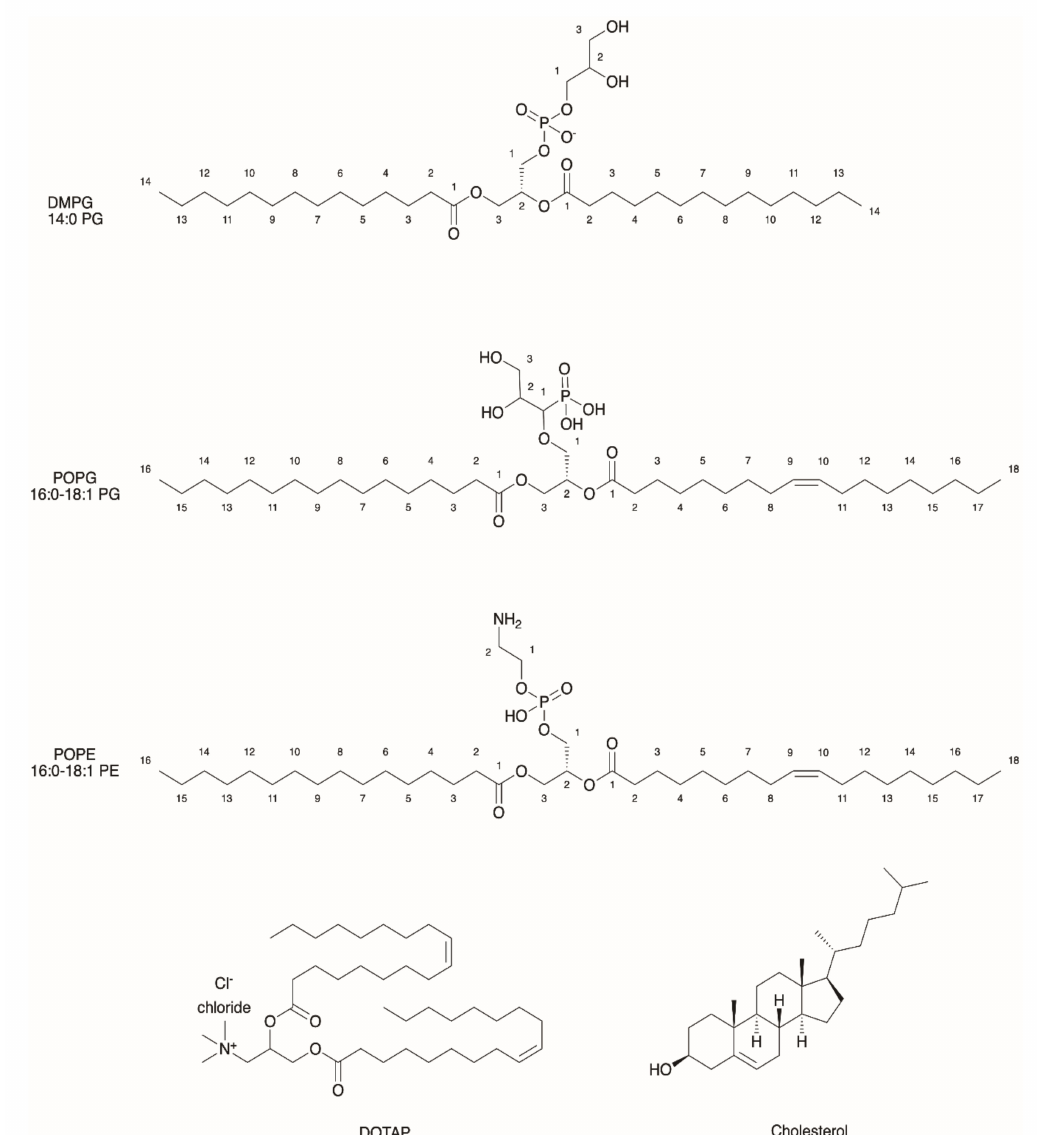
Figure 2. Structures of further lipids (apart from phosphatidylcholines) that were used for the generation of liposomes with photosynthetic activity. Abbreviations are listed in the footnote of Table 1. The number-based nomenclature, which is given below the common abbreviation, is explained in the legend of Figure